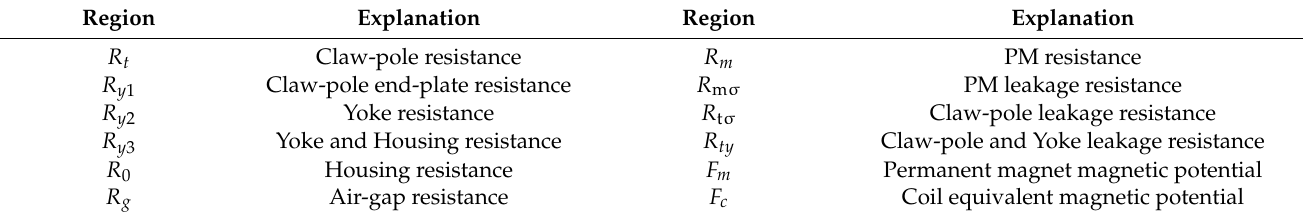
Figure 6. Equivalent magnetic circuit modeling. Table 2. Equivalent reluctance of each region.